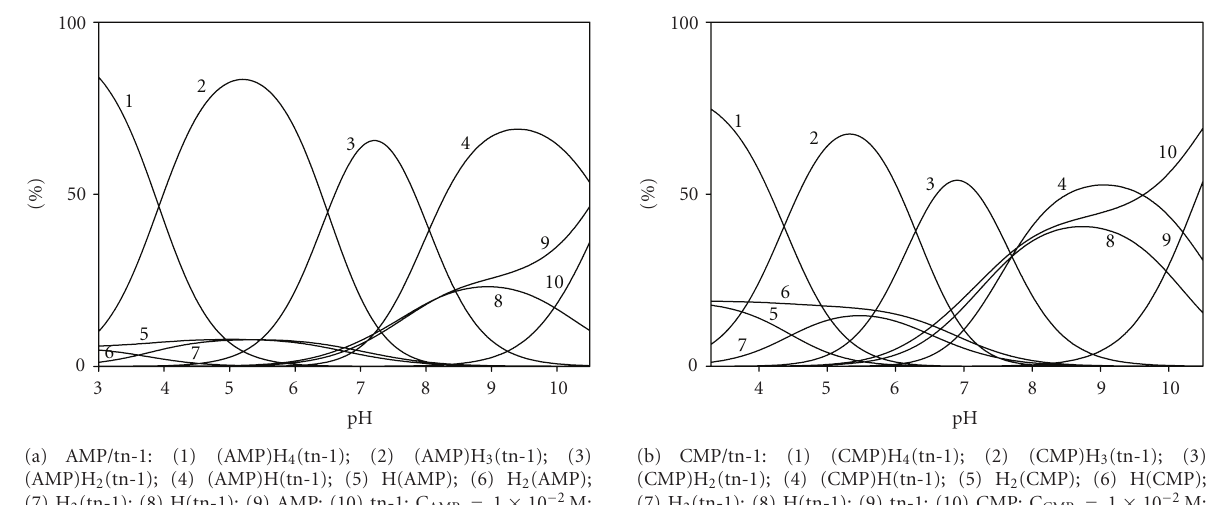
Figure 3: Distribution diagrams for the AMP/tn-1 and CMP/tn-1 systems; percentage of the species refers to total ligands.